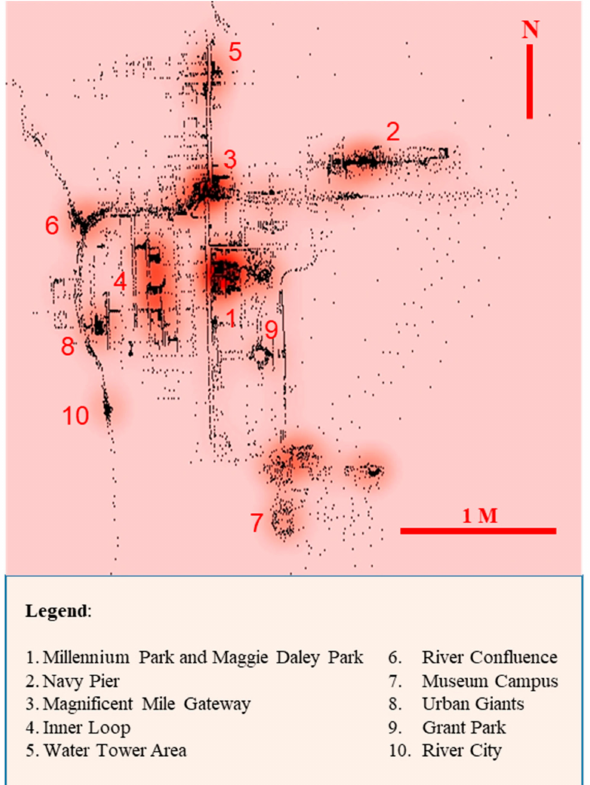
Figure 2. Map shows spatial distribution of uploaded photographs while applying the kernel density method, illustrating the identified 10 socio-spatial clusters. Color variation indicates the intensity of the taken photographs: the heavier color indicates a greater number of registered photographs, and the lighter color indicates a lesser number.